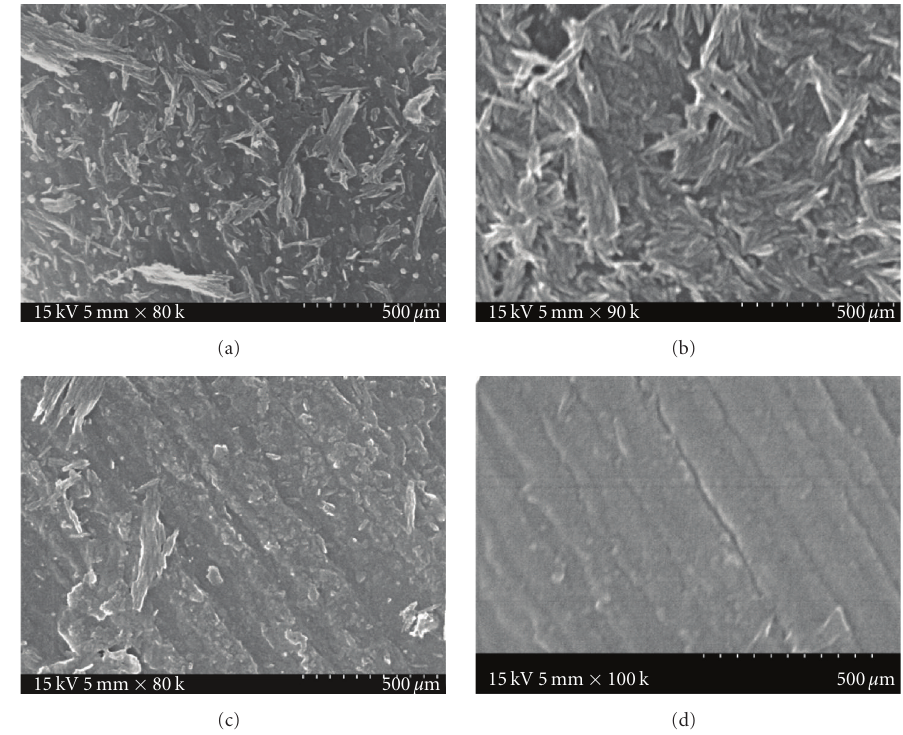
Figure 5: HRSEM of microstructures seen after electrochemical deposition of iron on carbon fiber, (a) at − 0.7 V using multipotential stepping, (b) using − 0.7 V continuous potential deposition, (c) using − 1.1 V using multipotential stepping, and (d) using − 1.1 V continuous potential